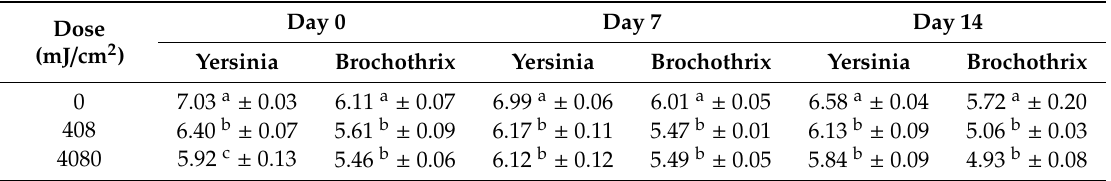
Table 4. Mean and standard error values of the bacterial counts of Yersinia enterocolitica and Brochothrix thermosphacta on rolled fillets of ham depending on the UV-C dose and storage day ( n =